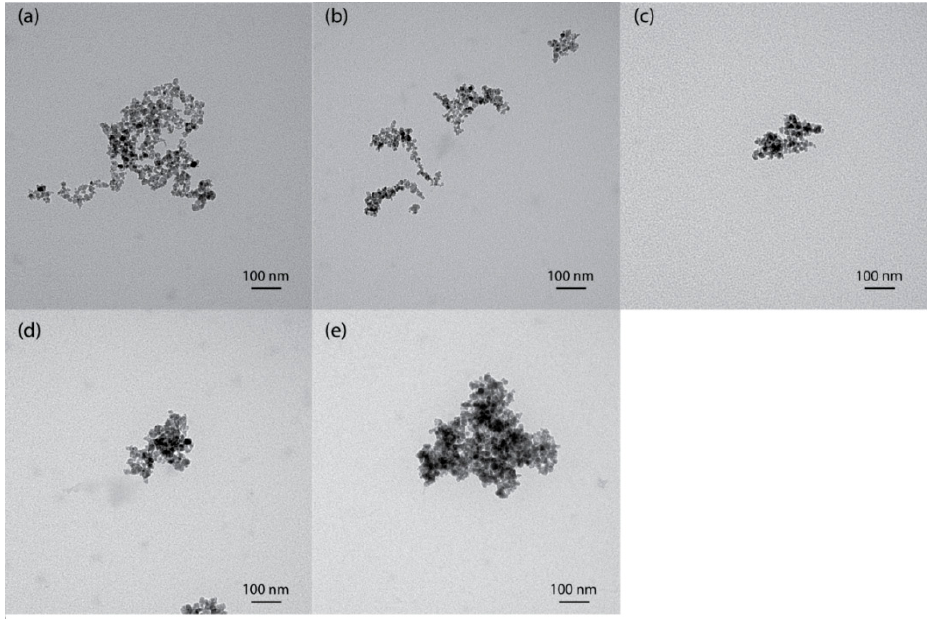
Figure 1. TEM images of ( a ) MNPs; ( b ) NH 2 -MNPs; ( c ) PAA-8k-MNPs; ( d ) PAA-100k-MNPs; and ( e ) PAA-450k-MNPs.